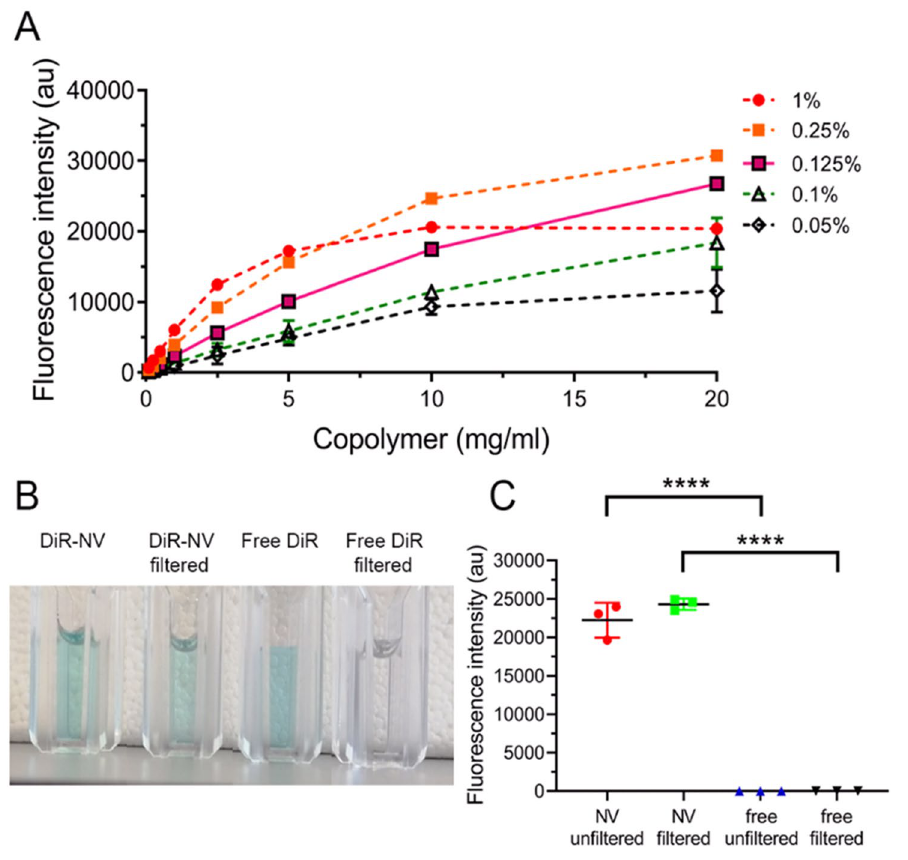
Figure 3. Formation of DiR loaded NV. ( A ) Fluorescence intensity of different wt% loadings of DiR in NV at different concentrations of copolymer (0.1–20 mg/mL) in PBS. Solid line indicates the most linear increase in fluorescence intensity (0.125 wt% loading DiR). ( B ) Macroscopic images of DiR-NV and free DiR, pre and post filtration (0.2 μm). ( C ) Fluorescence intensity of 0.125 wt% DiR-NV and free DiR pre and post filtration. Fluorescence intensity data represents mean ± SD. **** P < 0.0001. DiR 1,1 ′ dioctadecyl 3,3,3 ′ ,3 ′ -tetramethylindotricarbocyanine iodide, PBS phosphate buffered